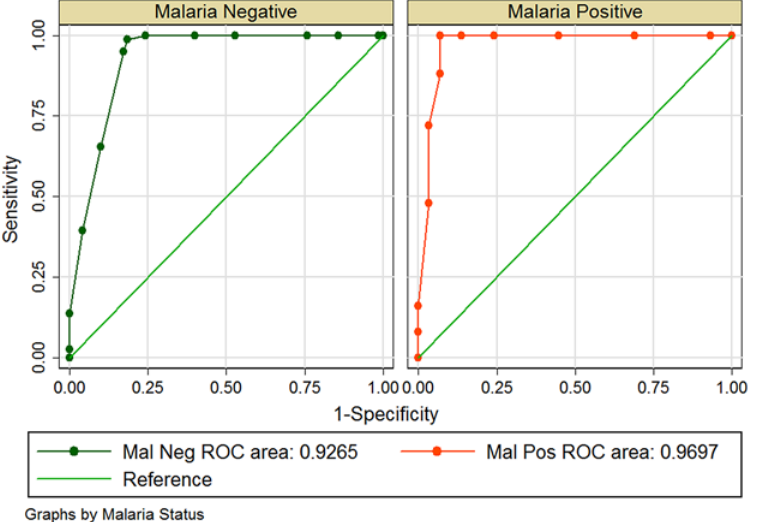
Fig 5. Area under the Receiver Operator Characteristics (ROC) curve for G6PD RDT performance considering malaria status of